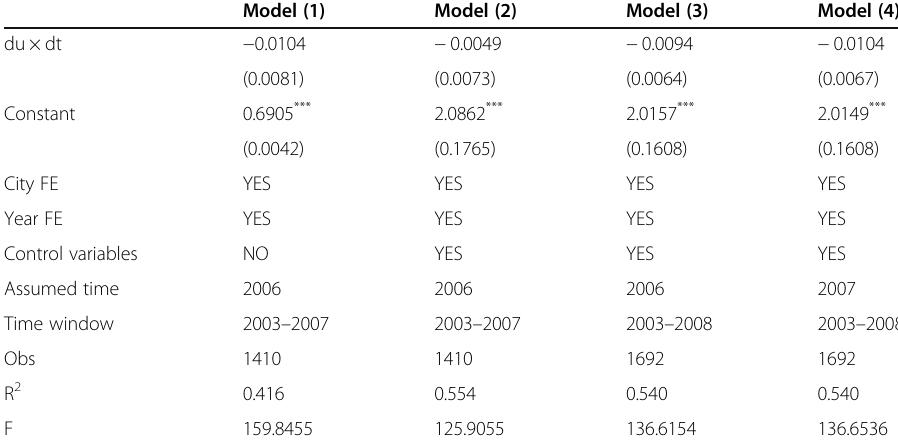
Table 5 Counterfactual test of regression